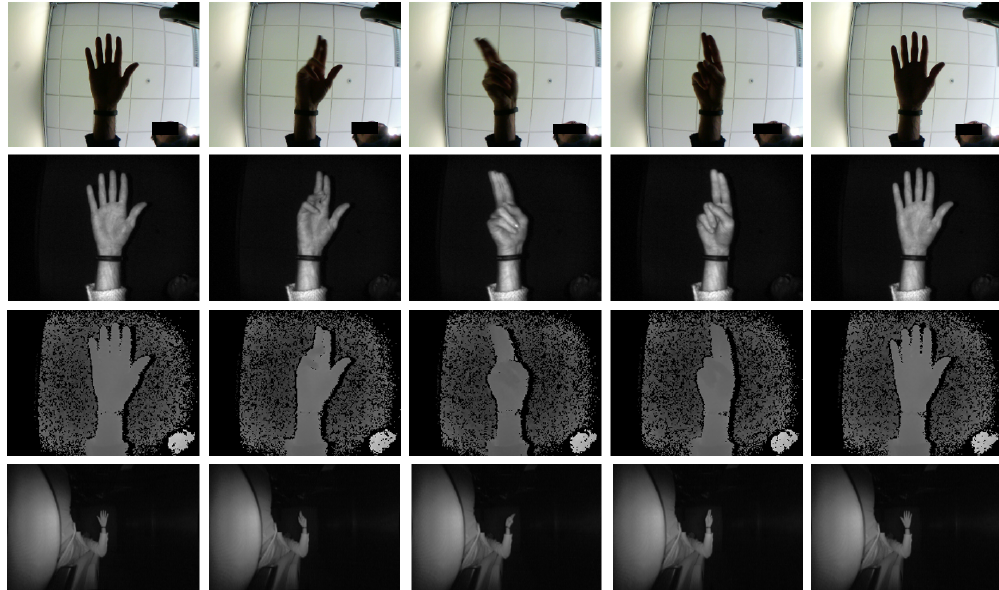
Figure 2. Sample of multimodal data included in the Briareo dataset [20]. The first row contains RGB frames, the second contains Infrared (IR) frames, while the third contains depth maps. The last row reports the rectified frame of the infrared stereo camera (right view). As shown, RGB frames suffer the lack of an additional light source, while infrared and depth data clearly collect the driver’s hand. Frames are sampled from the gesture “clockwise rotation”.